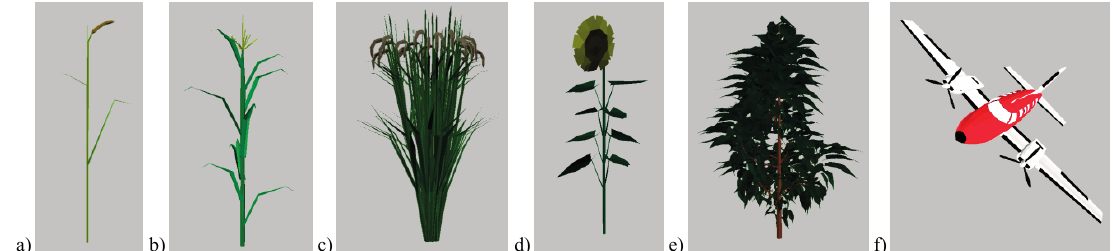
Figure 2. Examples of natural and artificial 3D objects imported by DART, simulated using triangular facets: ( a ) wheat plant, ( b ) corn plant, ( c ) rice canopy, ( d ) sunflower plant, ( e ) cherry tree and ( f )